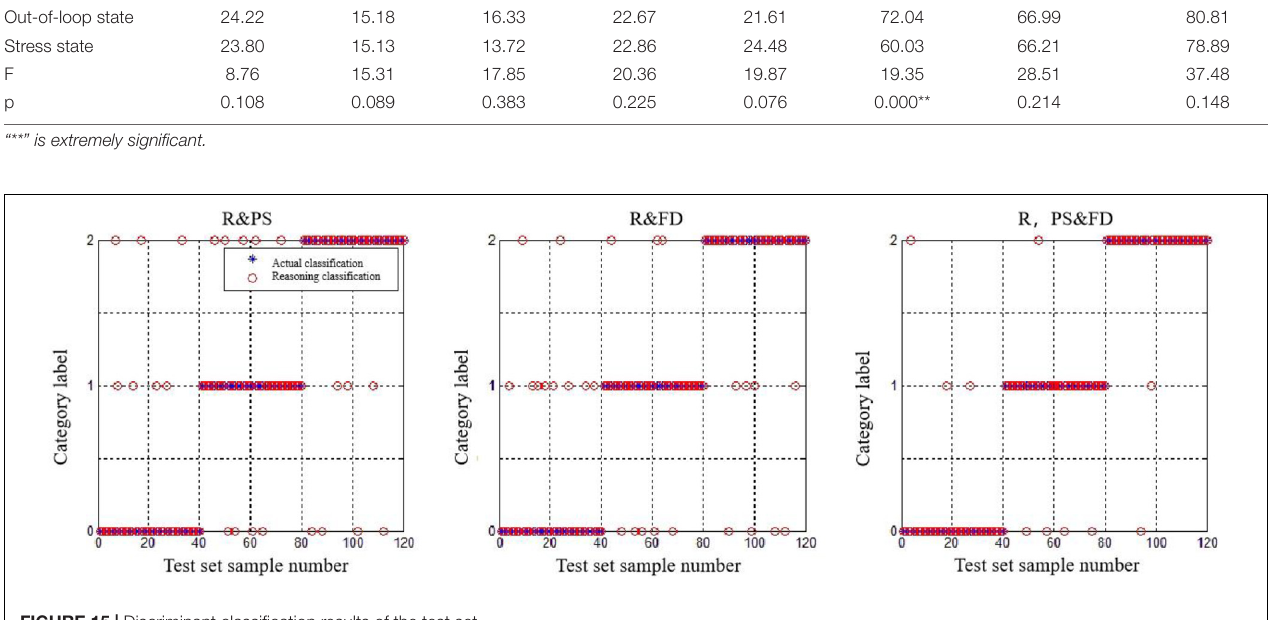
FIGURE 15 | Discriminant classification results of the test